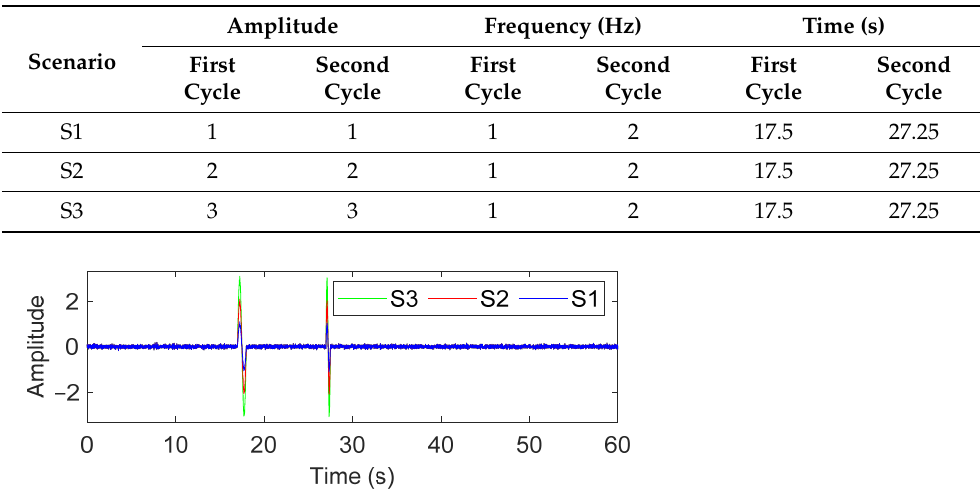
Figure 8. The simulated traffic-induced impulsive signal for all three scenarios with Figure 8 . The simulated traffic-induced impulsive signal for all three scenarios with 30% measure- 30% measurement ment noise .